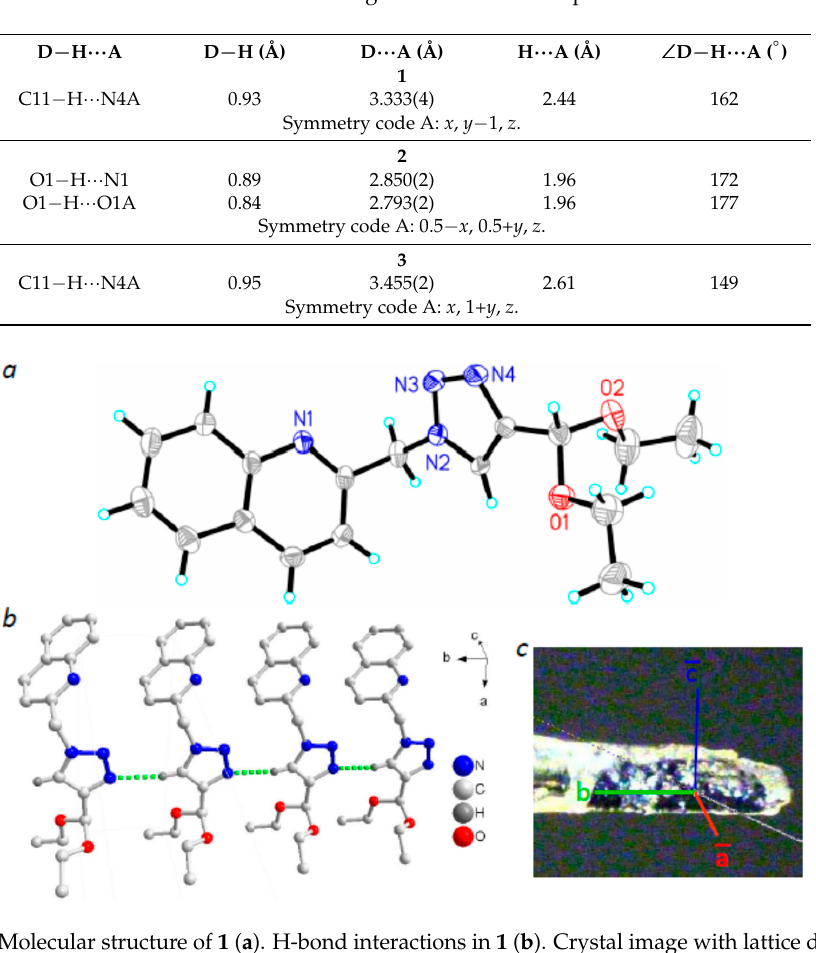
Table 1. Lattice H-bonding interactions in compounds 1 – 3 .